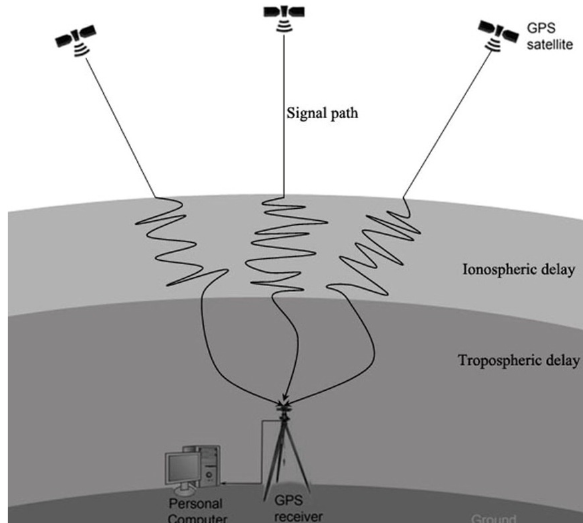
Figure 2. The illustration of how GPS signal can be used to sense the lightning activities through GPS PWV.